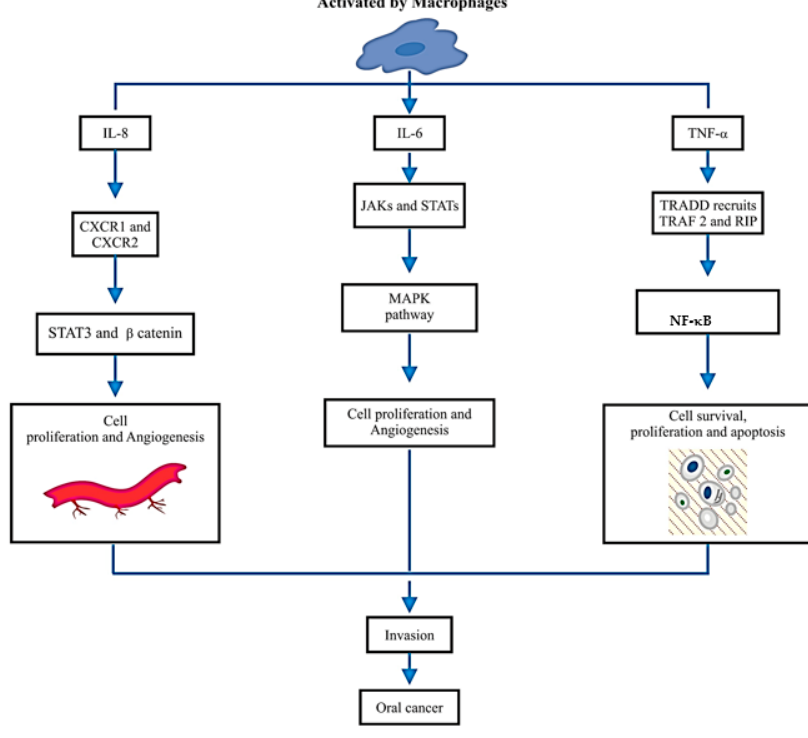
Figure 1. A schematic diagram illustrates the activation of IL-8, IL-6 and TNF- α through activated macrophages and the range of their signalling pathways in tumor microenvironments.